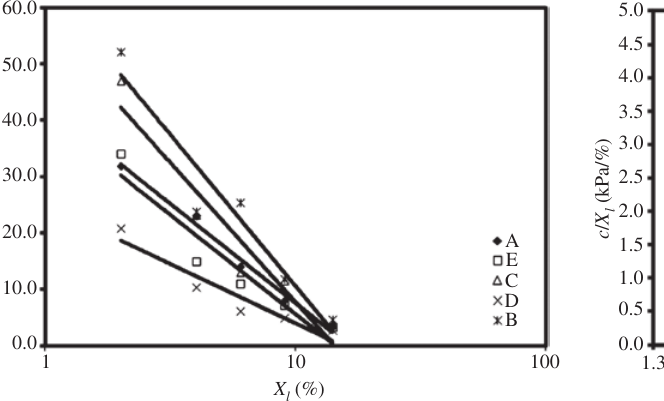
Figure 8 Normalized limiting stress versus gravimetric lignin content.